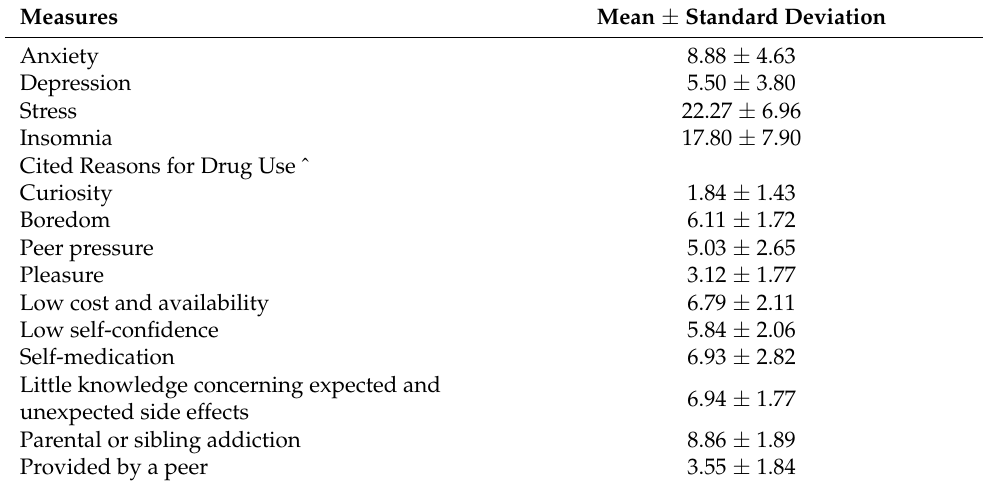
Table 2. Mean scores and standard deviations for psychological measures and cited reasons for drug use.